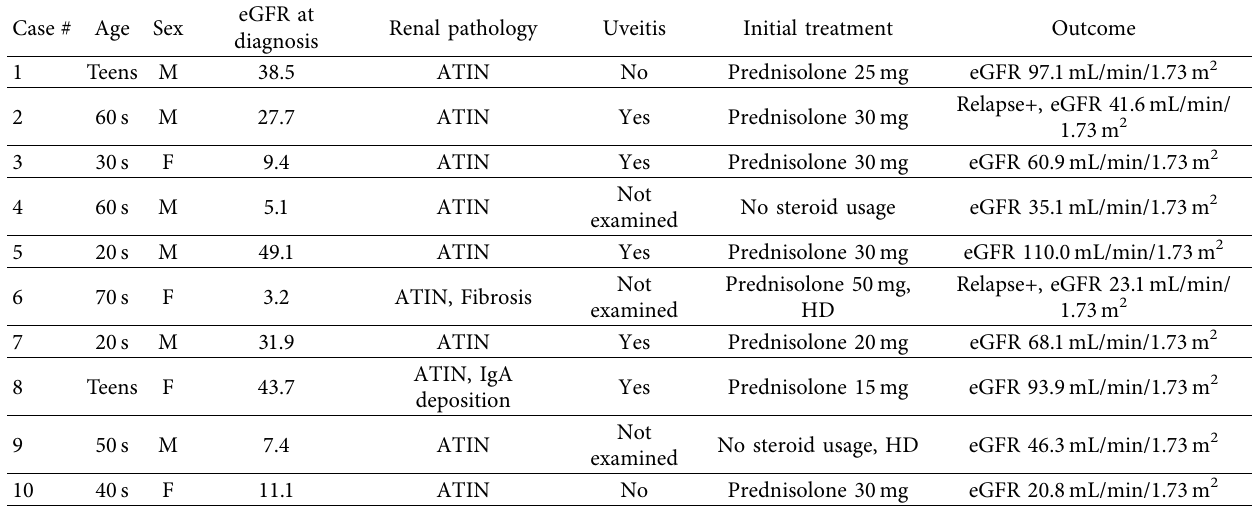
Table 2: Ten cases of biopsy proven acute tubulointerstitial nephritis from a single center in a rural area from 2008 to 2021. Case # Age Sex